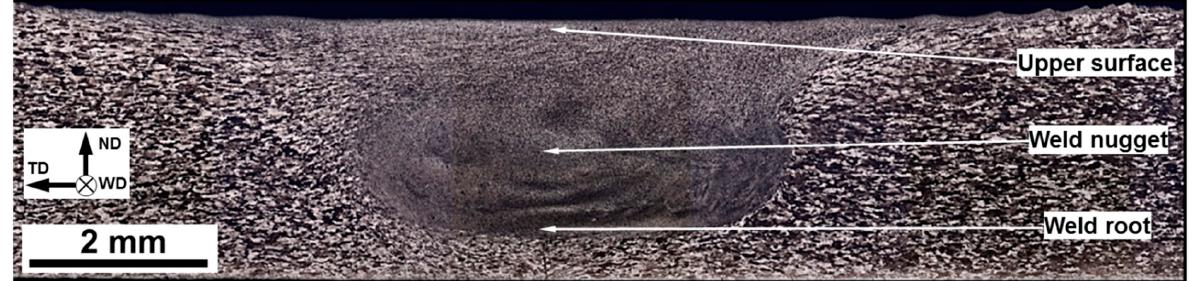
Figure 2. Optical image of the weld cross-section of the low-heat-input weld with indicated areas of microstructural observations. ND, TD, and WD are normal direction, transverse direction, and welding direction, respectively. In the micrograph, retreating side is left and advancing side is right.